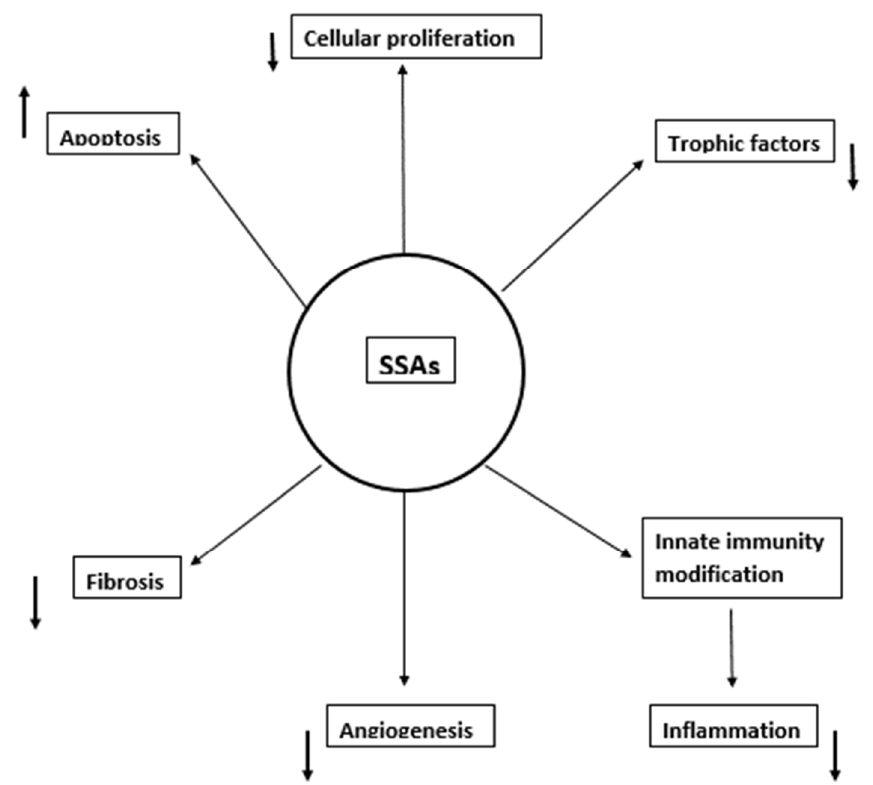
Figure 1. The several potential mechanisms implicated in HCC inhibition.